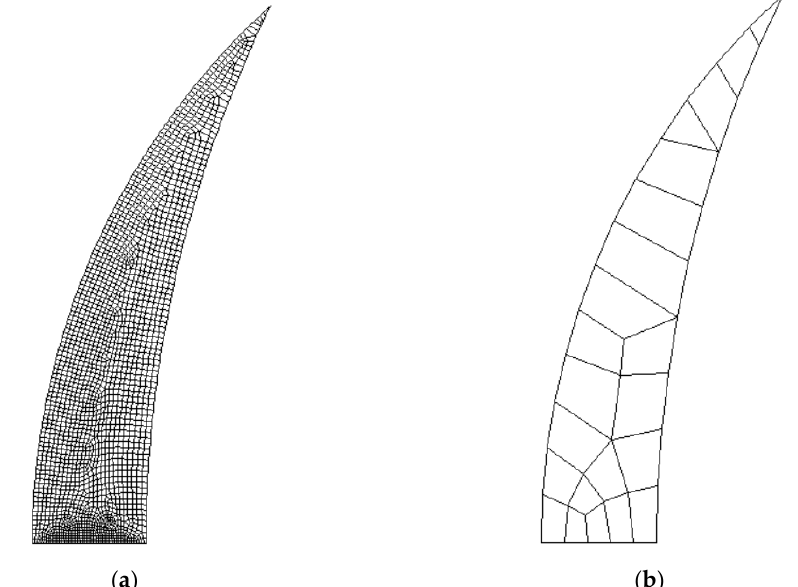
Figure 3. Evaluation of the strain energy density (SED) mesh sensitivity: ( a ) Number of elements = 2049, W = 2.8431 MJ/m 3 ; ( b ) Number of elements = 23, W = 2.8398 MJ/m 3 .